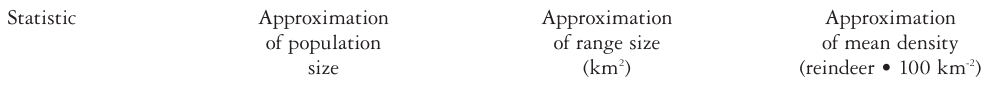
Table 3. Various statistics for 86 reindeer populations in Siberia and the Far East of Russia.